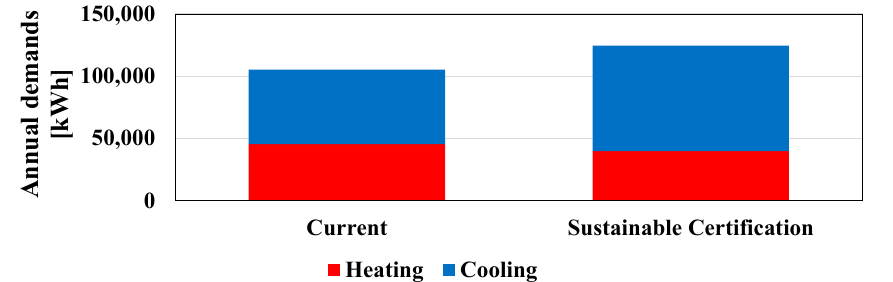
Figure 16. Total energy consumption for air-conditioning. The energy demands correspond to the current and hypothetical buildings built following the guidelines for sustainable certi fi cation.